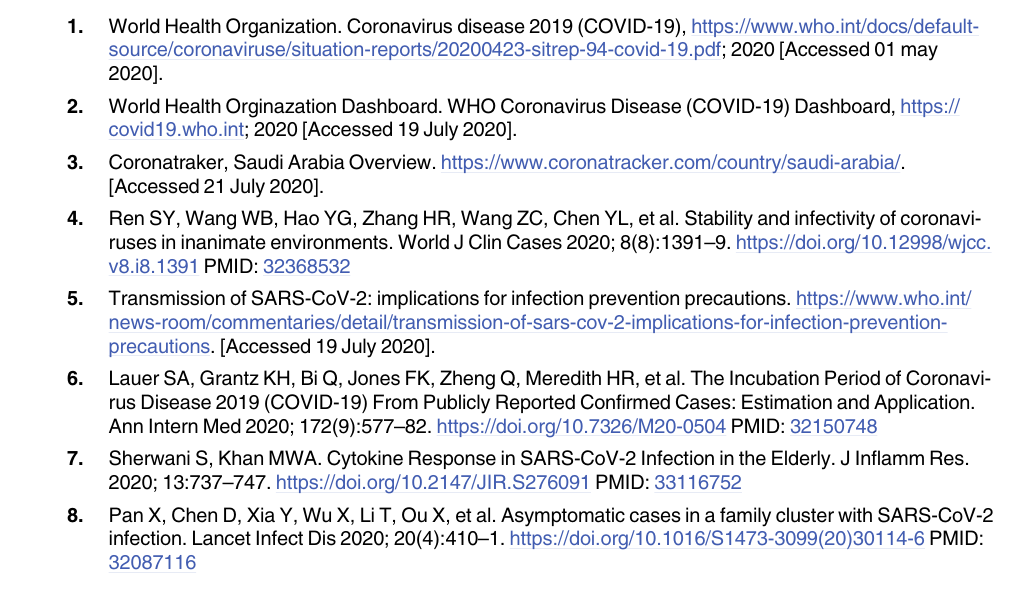
S1 Table. Mean rank of total scores in regards to knowledge